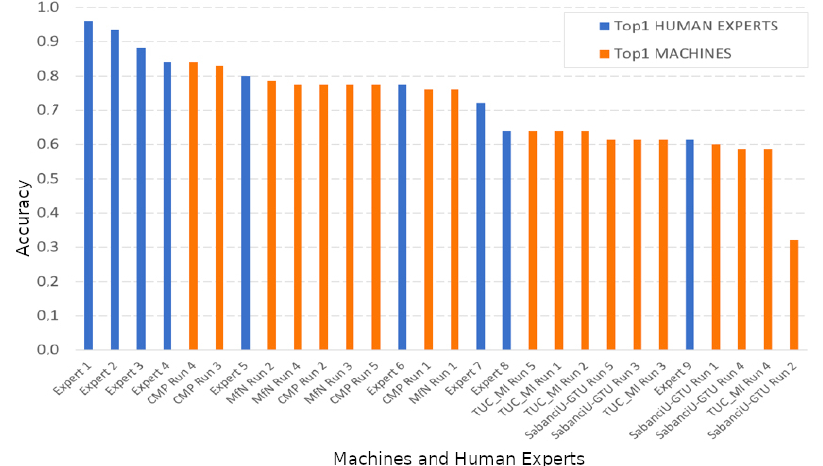
Figure 1. Identification performance achieved by the competing systems and participating human experts in PlantCLEF 2018. Figure taken from